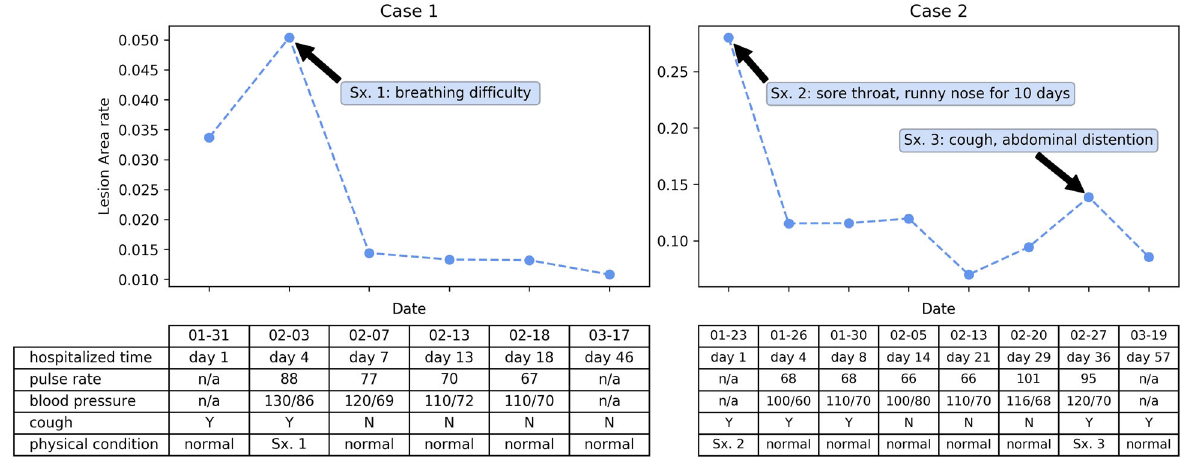
Fig. 6 Automated estimation of lesion burden change for longitudinal scans of hospitalized patients. Line curve shows the change of estimated lesion burden under different scanning dates for the two external cases collected in Hubei, China. The table shows the corresponding symptom recorded at each scanning date. Sx = symptom; Y = Yes; N =